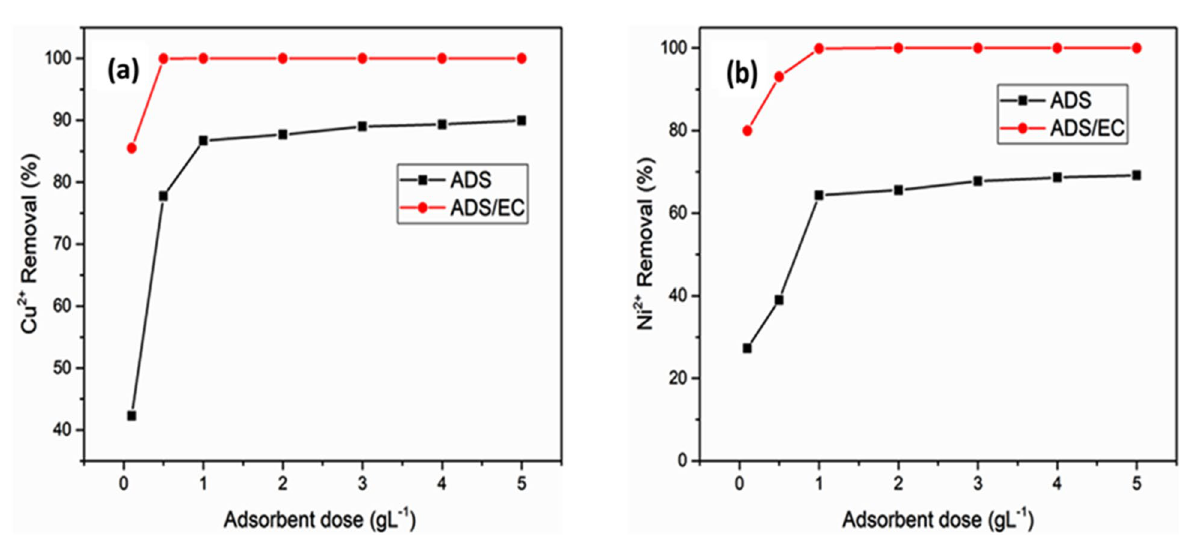
Figure 6. Effect of Adsorbent dose on ( a ) Cu 2+ and ( b ) Ni 2+ removal of the synthesized wastewater during the ADS and ADS/EC coupling processes (Initial conc. = 20 mg L −1 and Current density = 1.19 mA cm −2